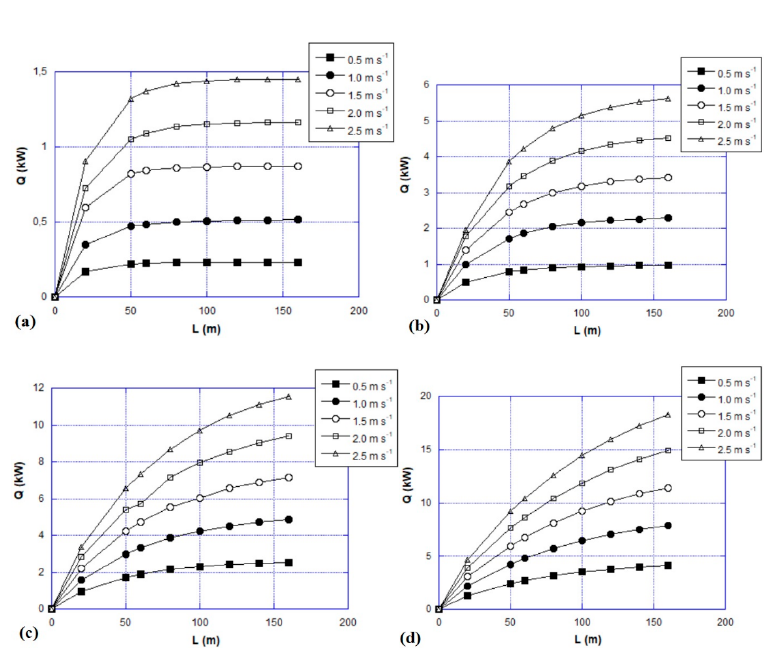
Figure 10. Power of the EAHX operating in heating mode vs length, parametrized for air velocity with: ( a ) D = 0.1 m; ( b ) D = 0.2 m; ( c ) D = 0.3 m; ( d ) D = 0.4 m.